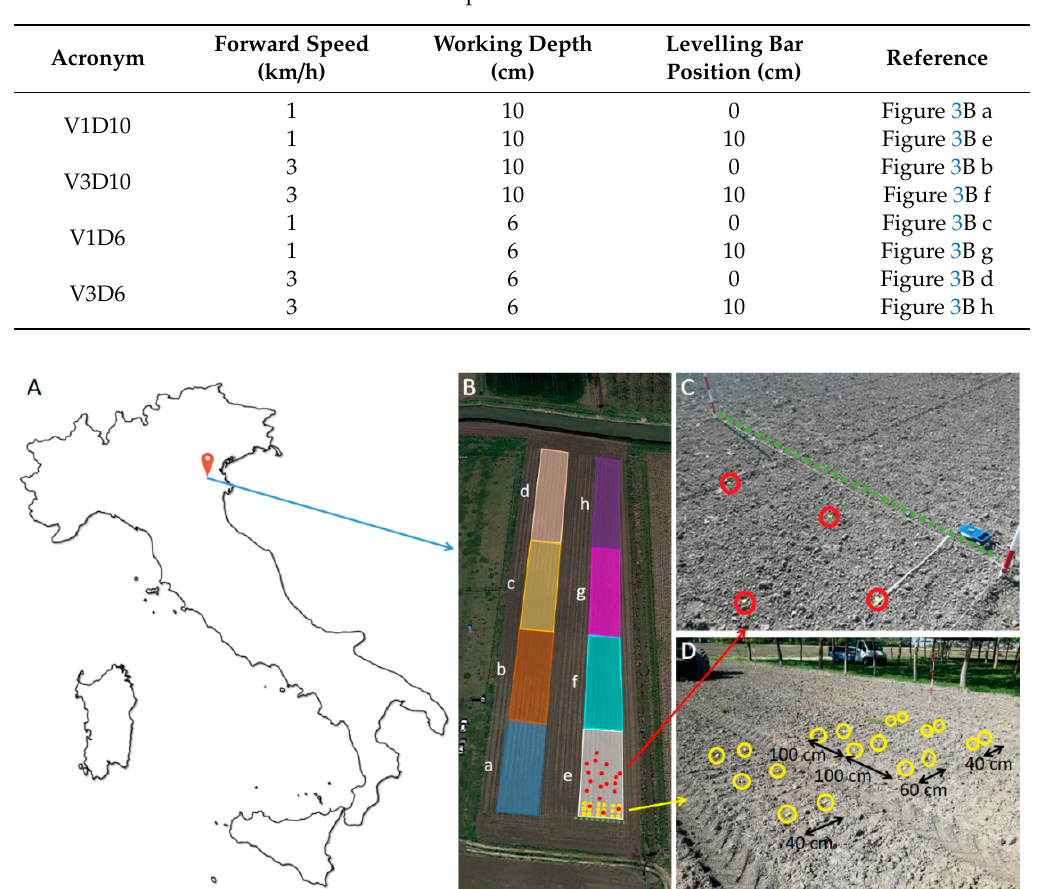
Figure 3. ( A )—Geographical localization of the experimental site in Italy. ( B )—Experimental area with representation of the experimental design. ( C )—Some of the tags after tillage operation. ( D )—Trackers distribution on undisturbed soil, before harrowing process.